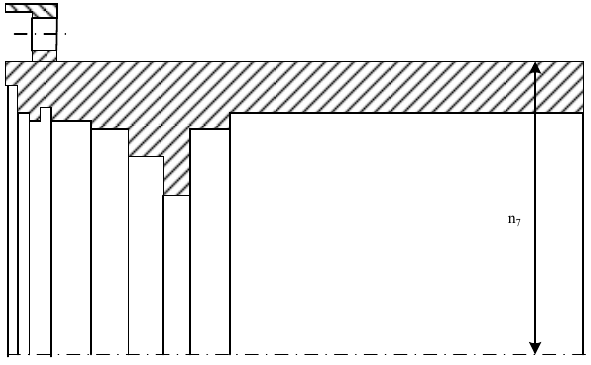
Figure 7. Optimal design parameters of C-axis.